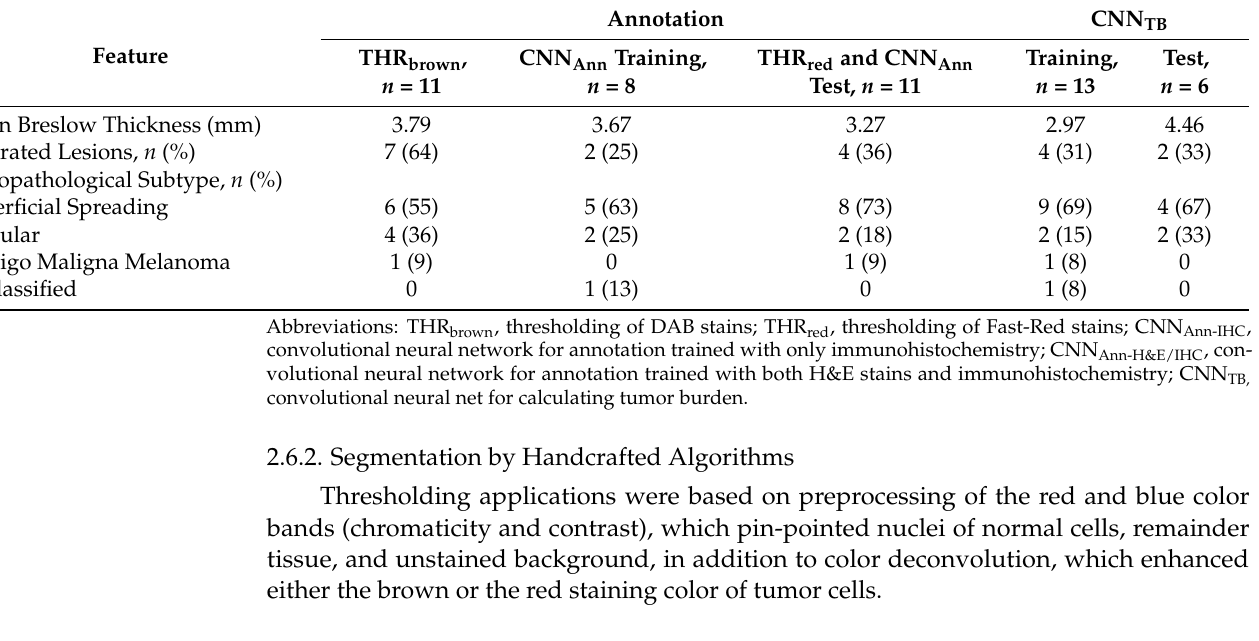
Table 1. Histopathological Characteristics of Included Melanomas.